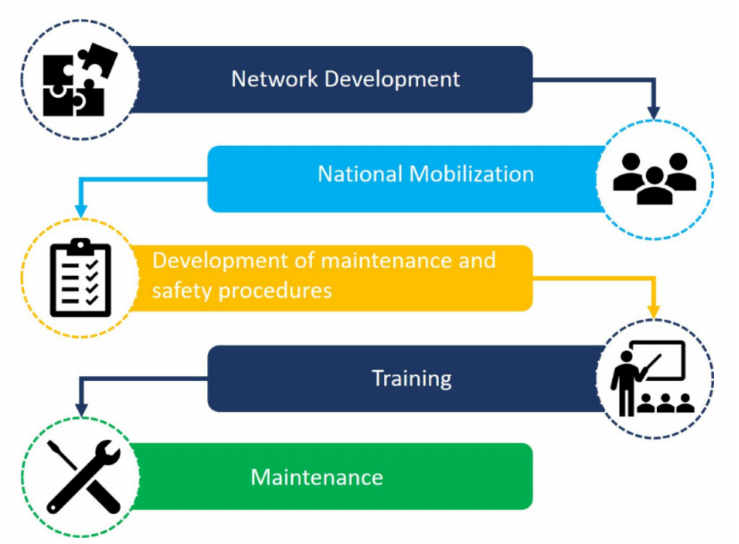
Figure 3. Flowchart of the main stages followed to structure the collaborative network for mainte- nance of ventilators.